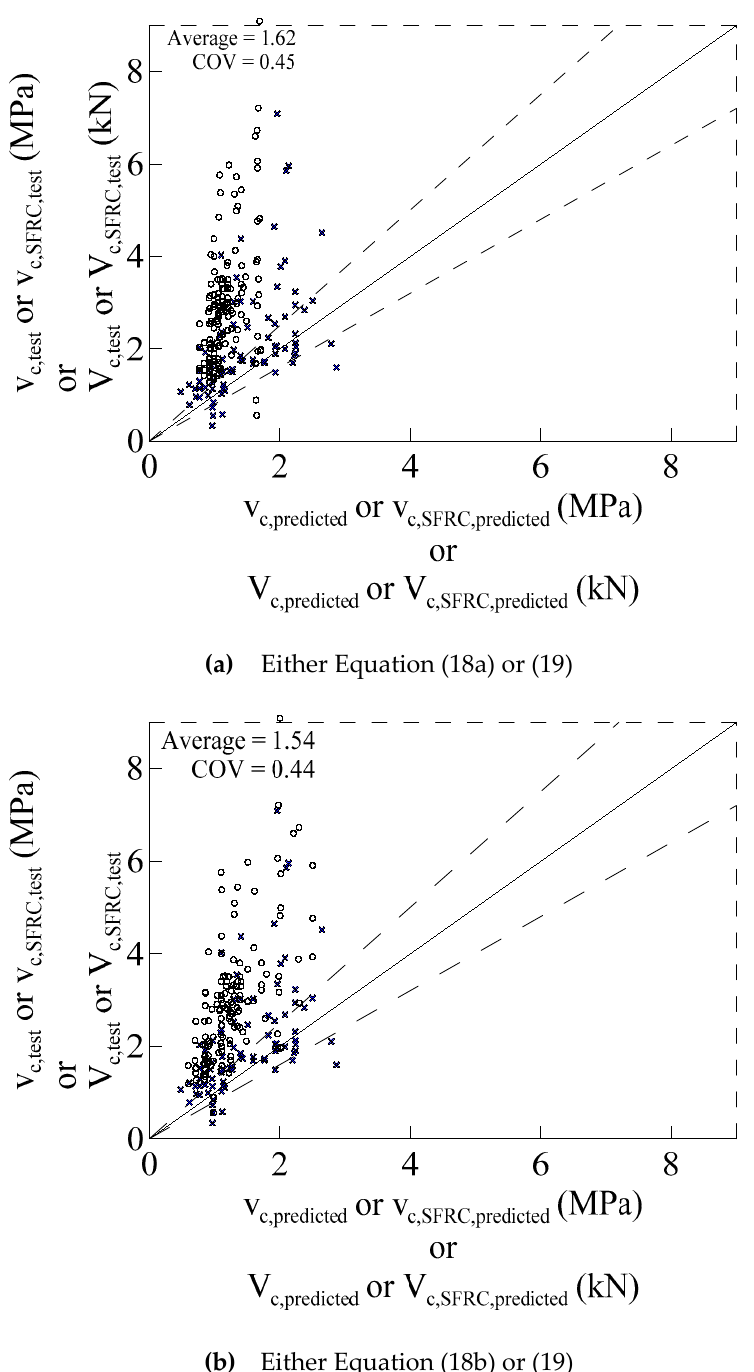
Figure 11. Comparison between experimental and prediction results based on ACI 318-19 Equations.